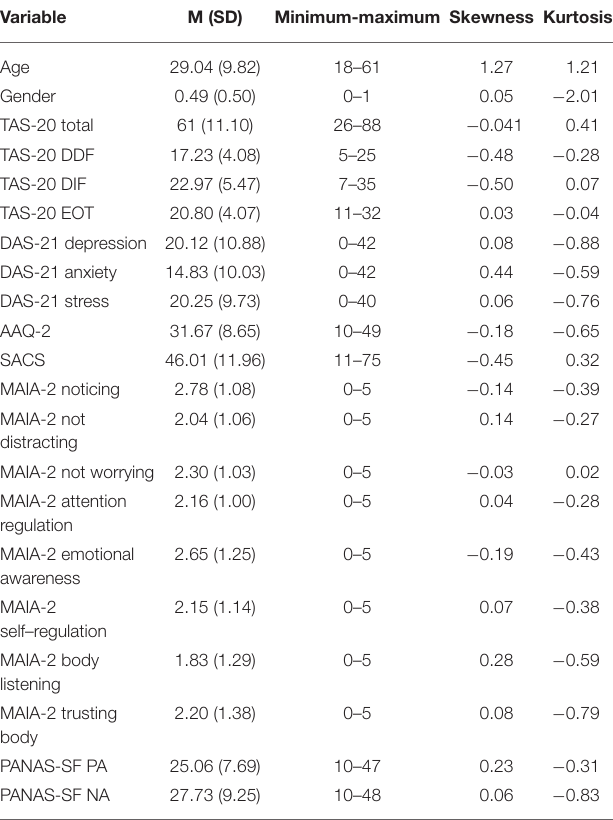
TABLE 2 | Descriptive statistics and normality scores of the variables. Variable